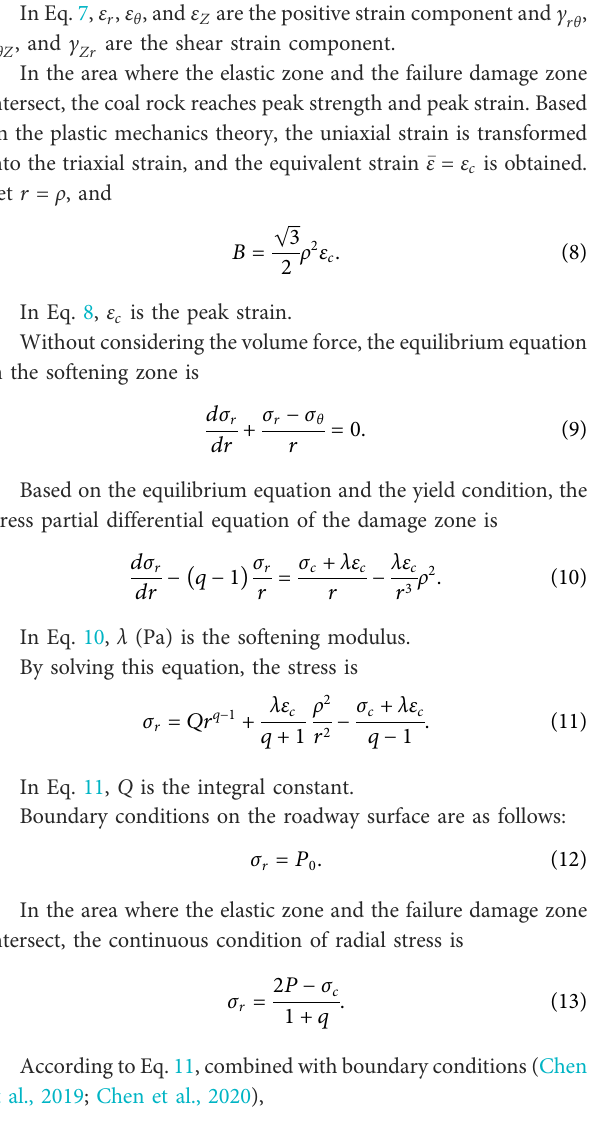
FIGURE 1 Analysis model of a rock burst in a circular